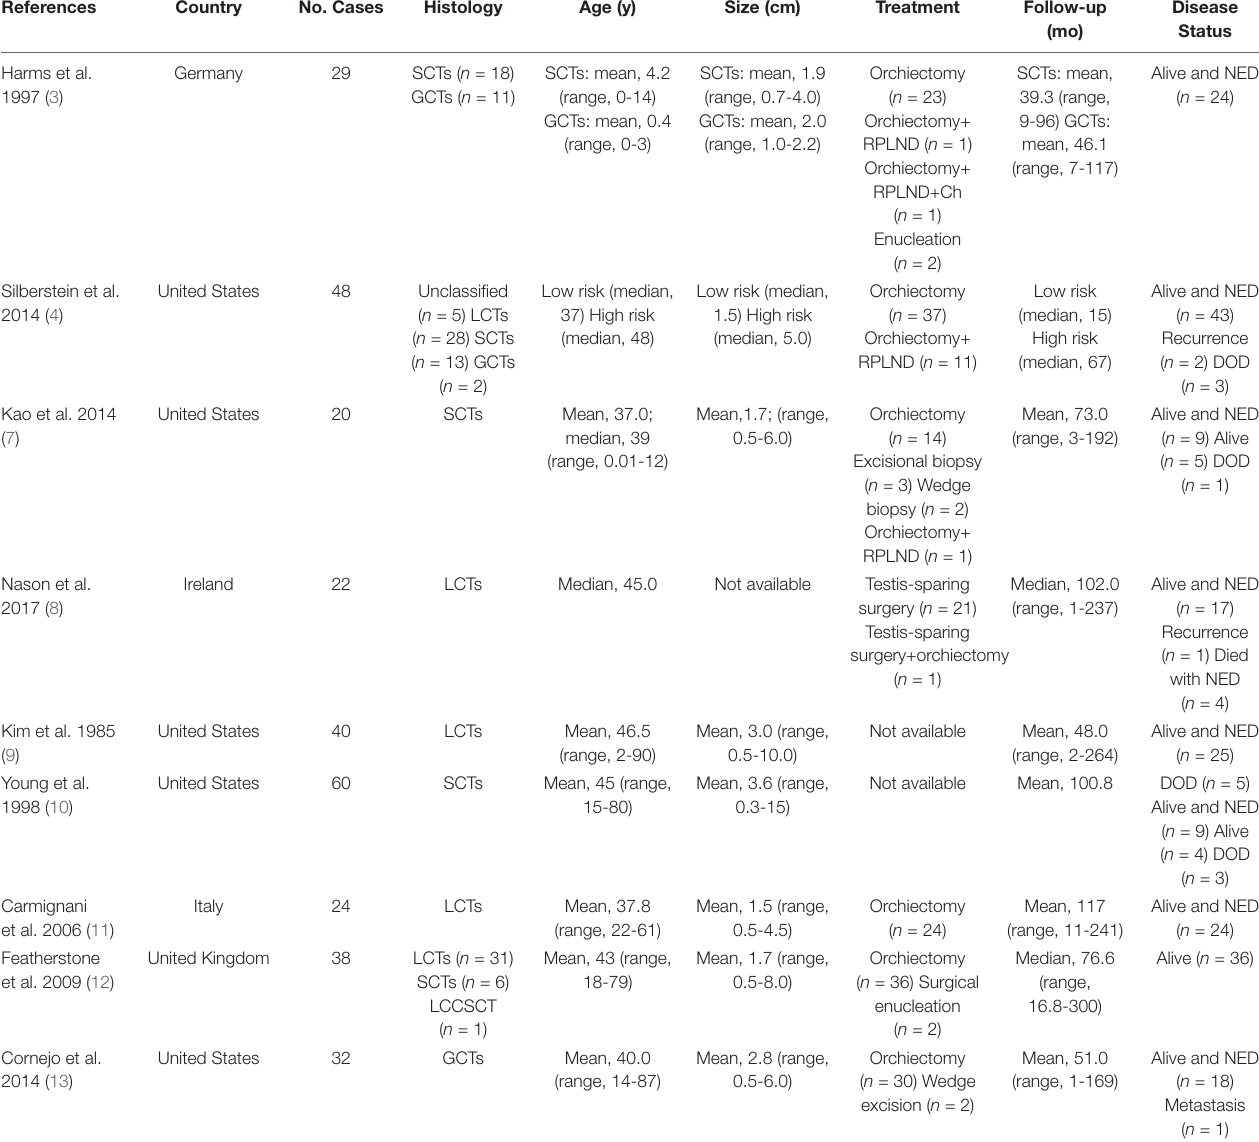
TABLE 2 | Summary of TSCSTs previously reported in the